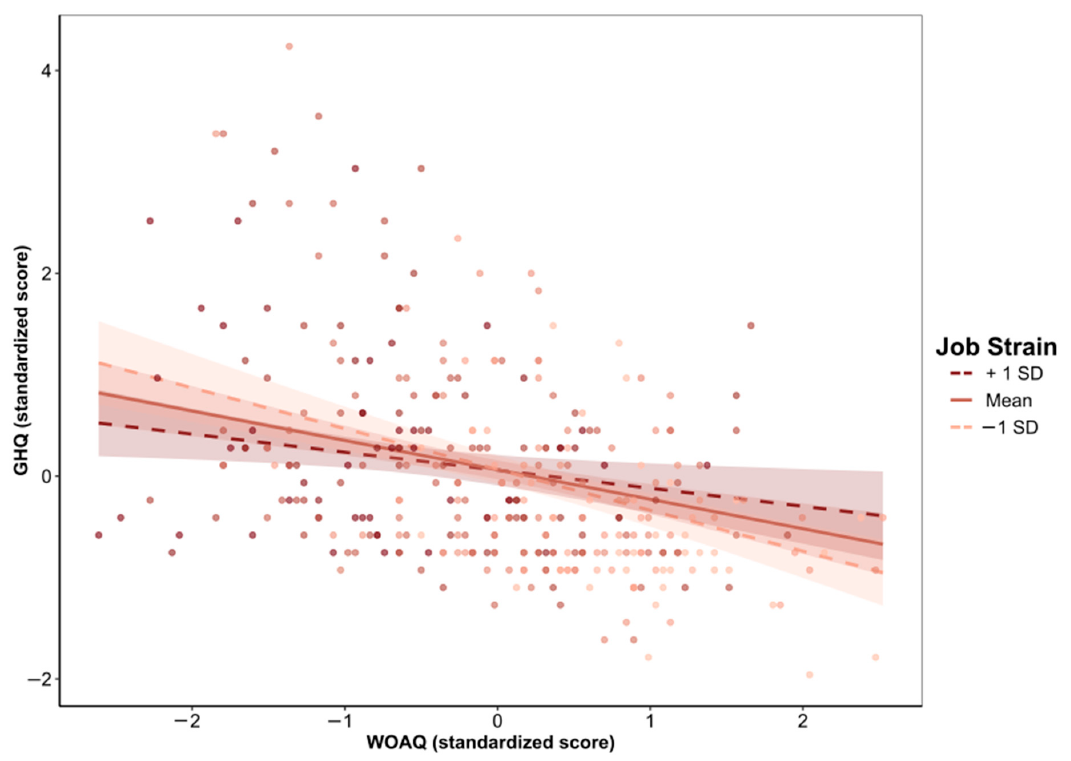
Figure 3. Simple slopes plot of the job strain model.